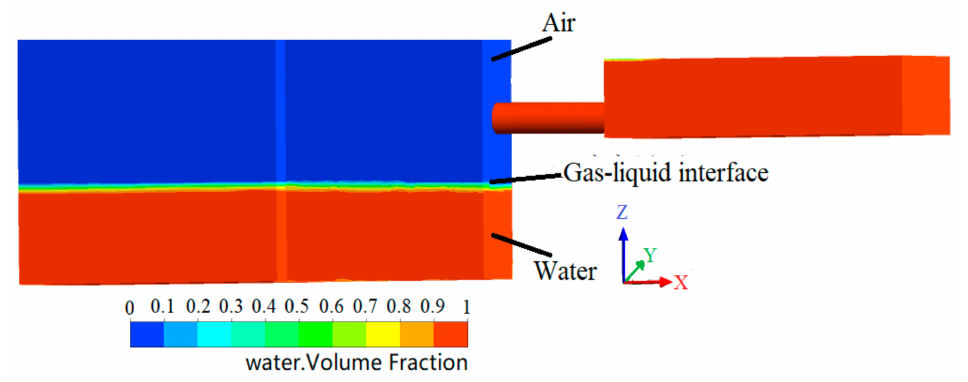
Figure 5. Initial gas–liquid distribution of the calculation